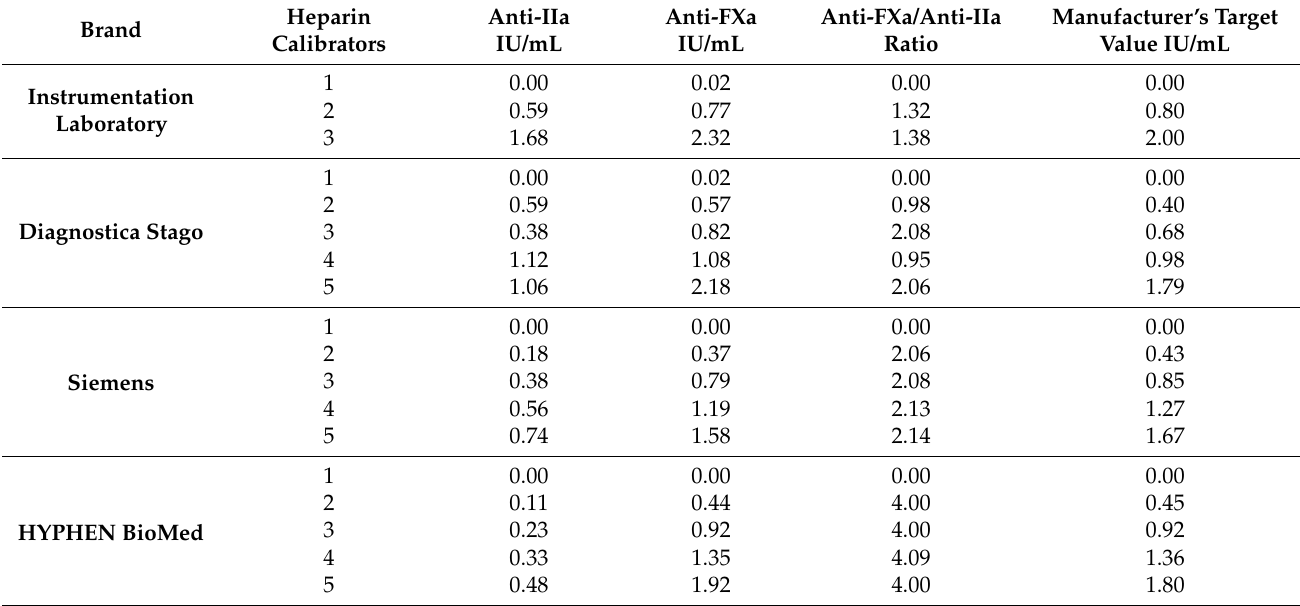
Table 5. Analysis of the various heparin calibrators from the different manufacturers by testing anti-FXa and anti-FIIa activities (IU/mL) as compared with the manufacturers’ claimed heparin concentrations and anti-FXa/anti-FIIa ratios: Diagnostica-Stago has 2 calibrators with UFH and 2 with LMWH; IL uses a combination of UFH and LMWH for each calibrator; Siemens and Hyphen BioMed calibrators are prepared with only